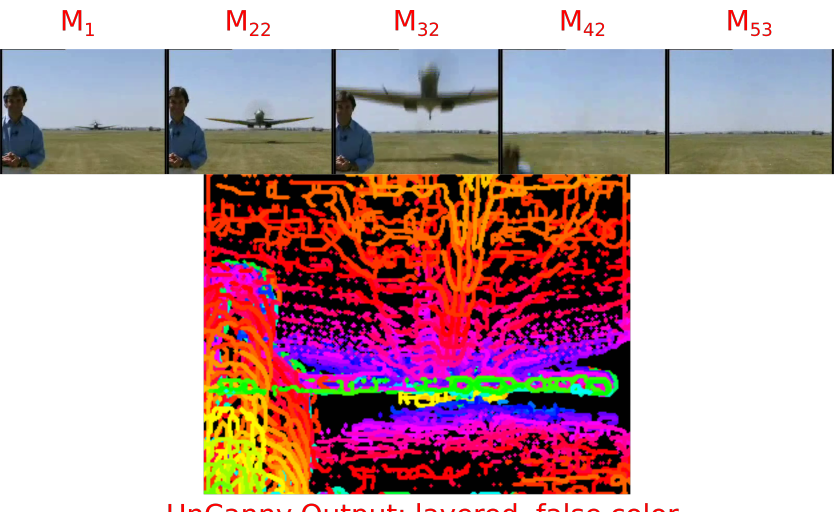
Figure 8. A video of a man ducking as a World War II era Spitfire warplane flies close overhead demonstrates the object tracking capabilities of the UnCanny method. A few frames of the video sequence are shown first to demonstrate the action and motion in the video. The colorful image below the action sequence reports the contours discovered by the UnCanny filter layered sequentially in color gradient. The action in the video generates distinct shapes related to the objects in motion, including the plane, the flinching man, the shadow of the plane, and the horizon as air currents from the plane disturb the